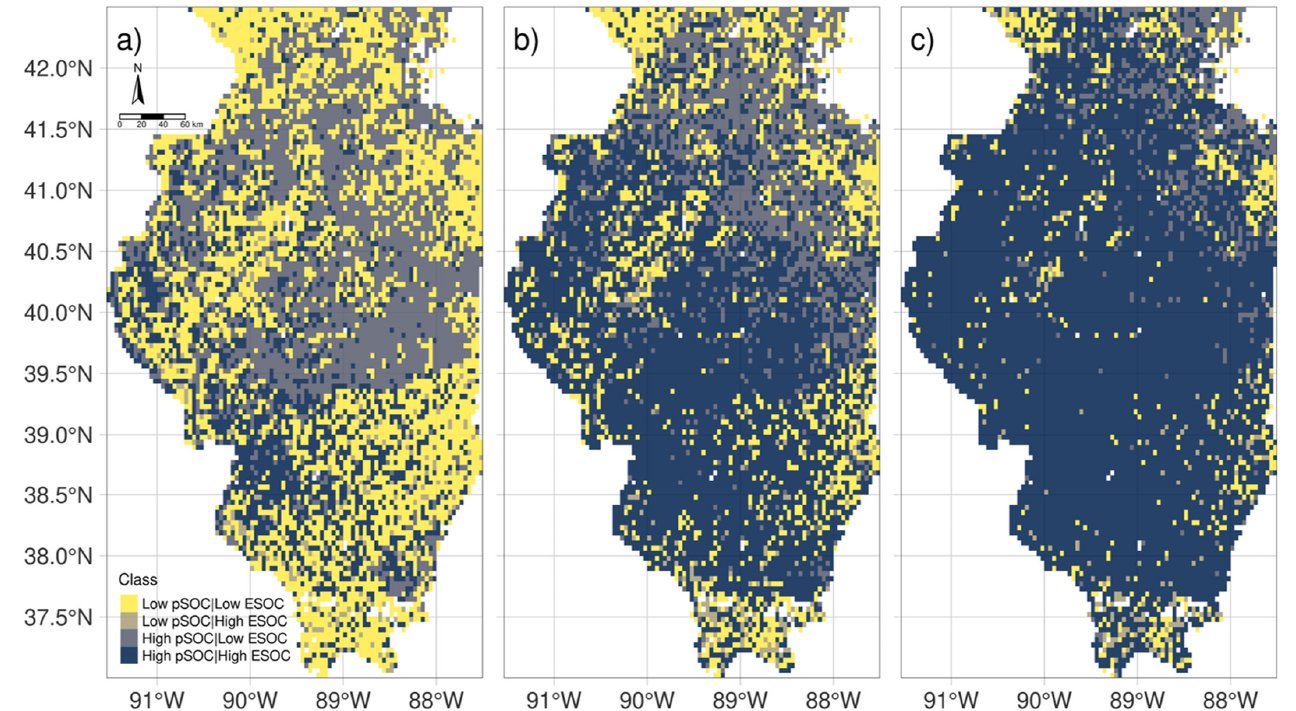
Figure 6. Probability and expected increase in SOC under corn-rye-soybean-rye rotation compared with corn-corn rotation in ( a ) 2010, ( b ) 2015, and ( c ) 2020. ESOC > 15% is classified as high and ESOC < 15% is classified as low, whereas pSOC > 0.75 is classified as high and pSOC < 0.75 is classified as low.